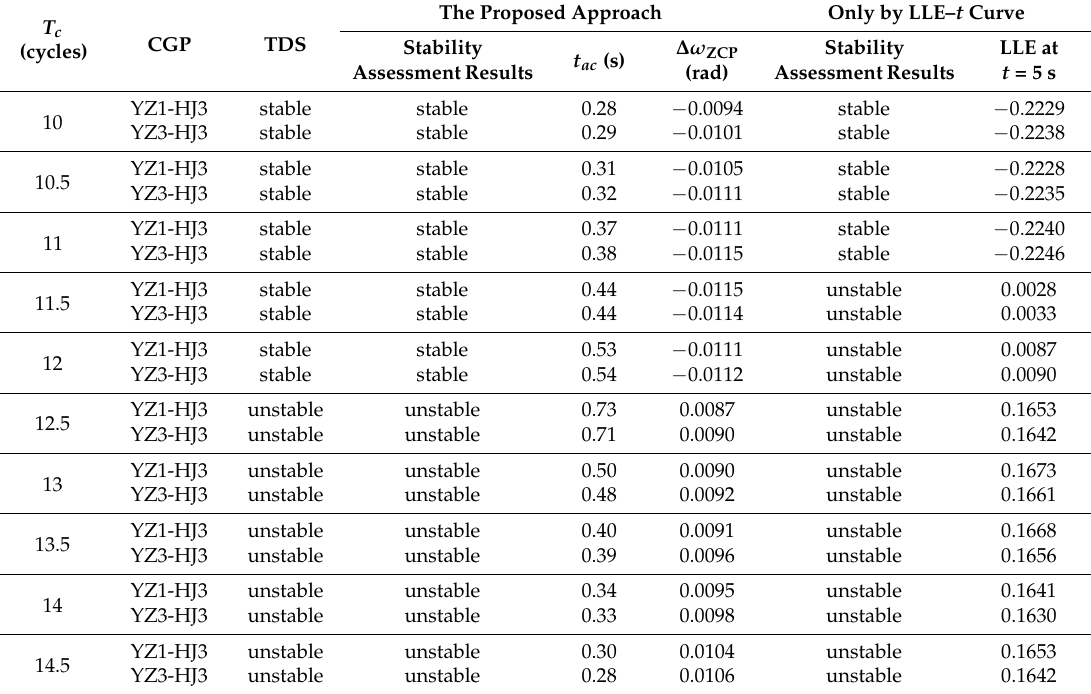
Table 2. The comparisons of the simulation results obtained by different assessment approaches for